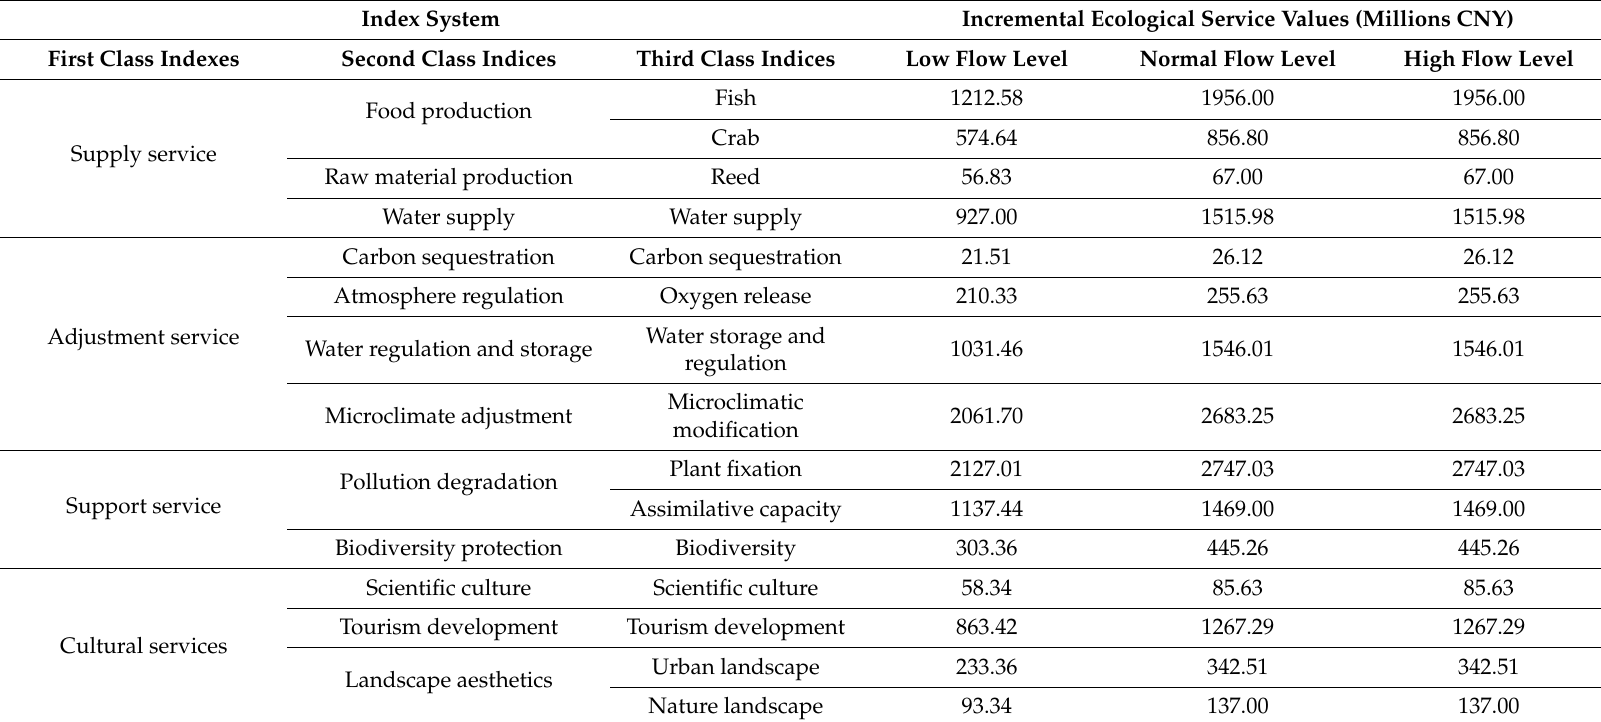
Table 4. Incremental values based on ecological service assessment index system in Jilin